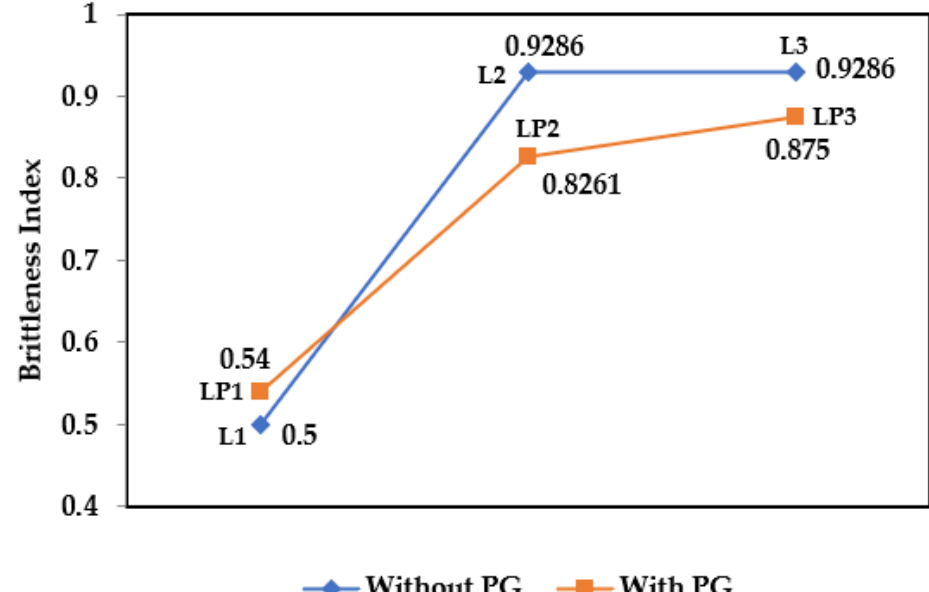
Figure 5. The brittleness Index of the lime-stabilized soil with and without PG.